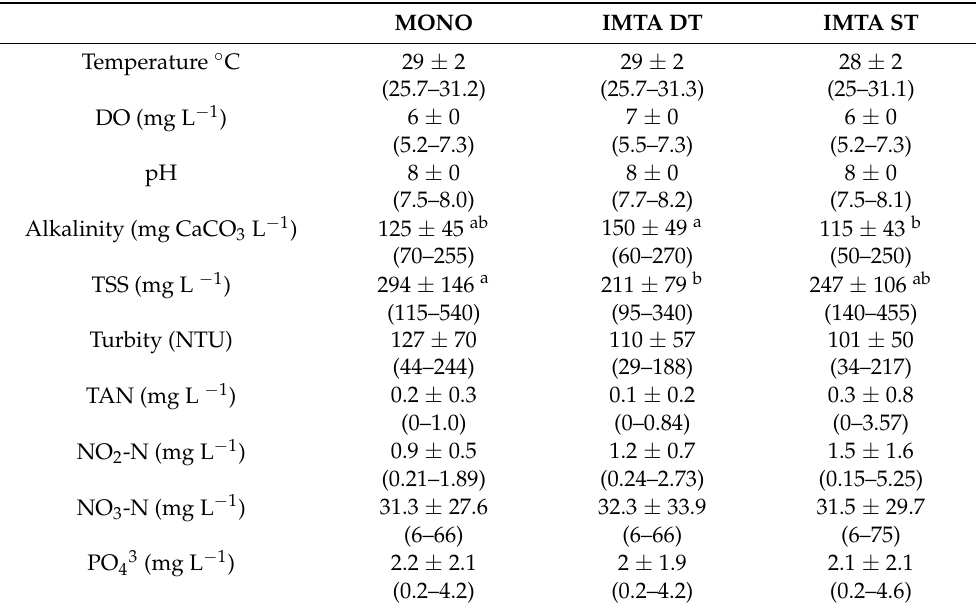
Table 1. Water quality parameters (mean ± standard deviation) of L. vannamei and O. niloticus during the experiment in the different treatments: MONO, IMTA DT, and IMTA ST.